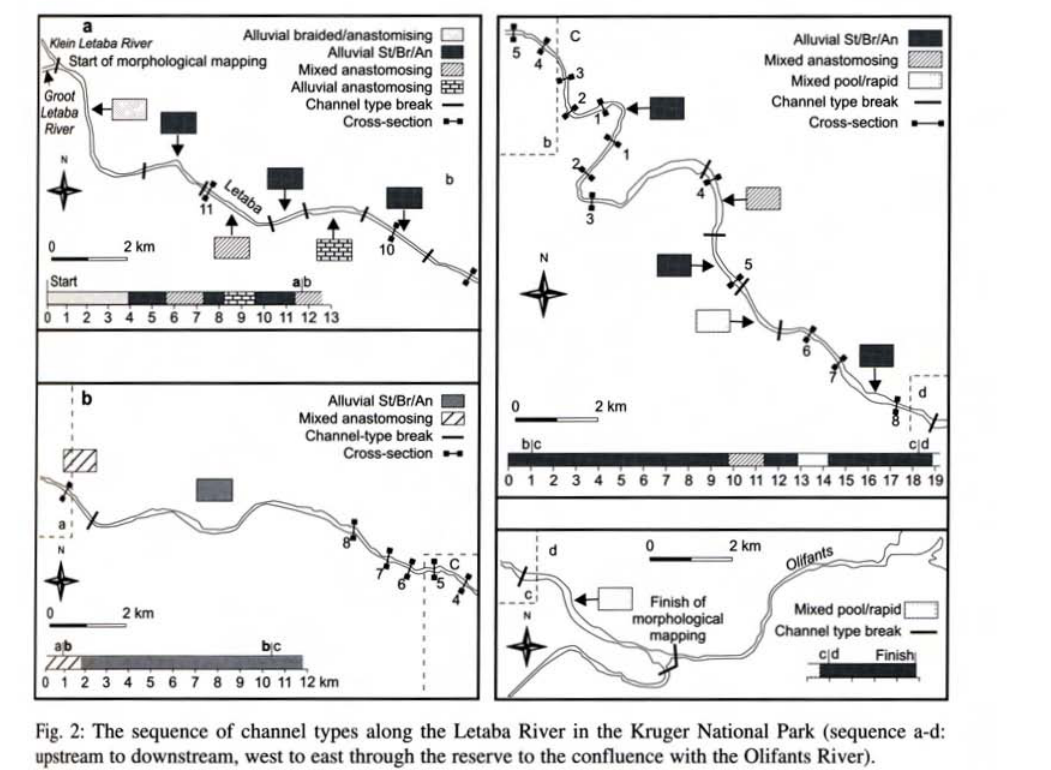
Fig. 2: The sequence of channel types along the Letaba River in the Kroger National Park (sequence a-d: upstream 10 downstream, weSI to east through the reserve 10 the conllLlence with the OlifanlS River).